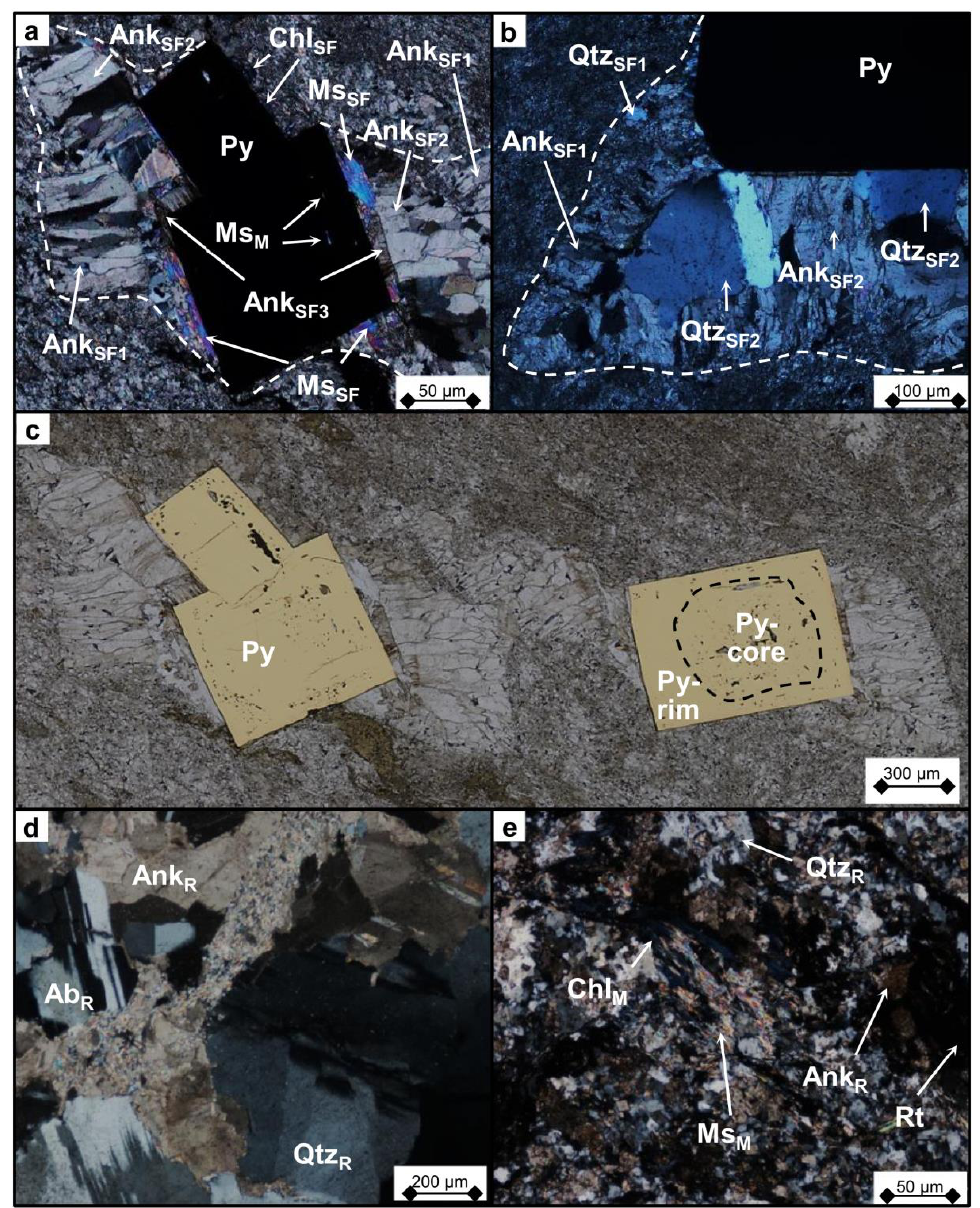
Figure 5. Photomicrographs under cross-polarized and reflected light showing the different microstructures observed in the metabasaltic fragments. ( a – c ) Fringes structures formed around a pyrite crystal, and minerals filling the strain fringes (SF). ( d , e ) Relict (R) and metamorphic (M) minerals. Mineral abbreviations and subscript definition are shown in Table 1.